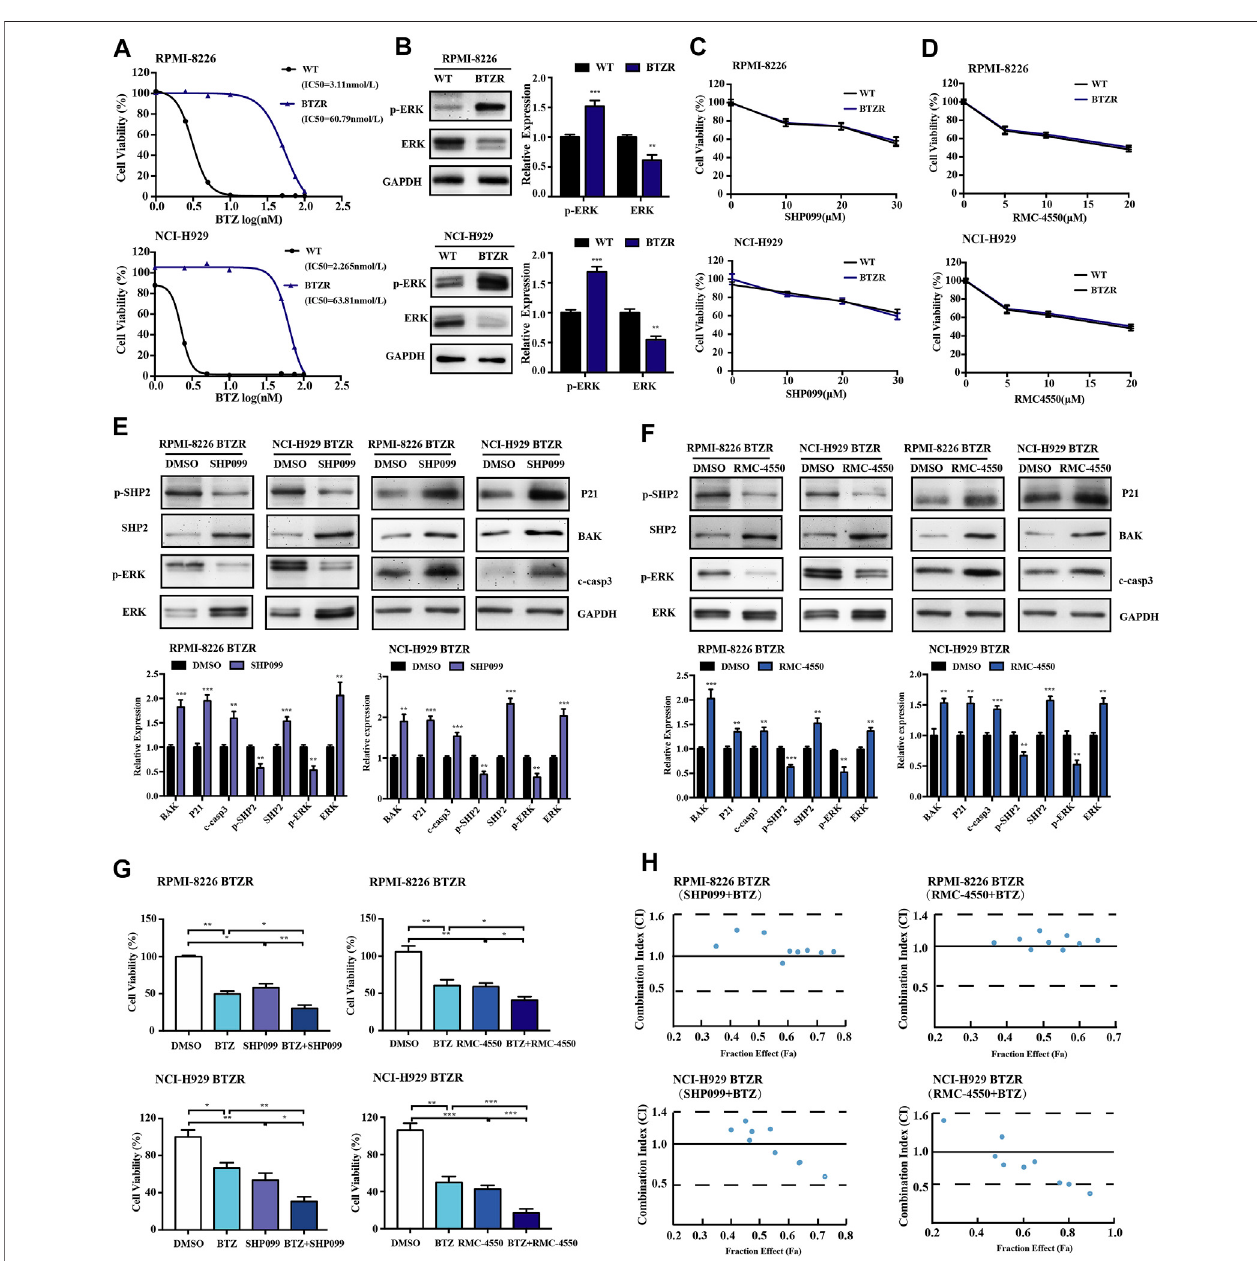
FIGURE 8 | Pharmacological inhibition of SHP2 with SHP099 or RMC-4550 is effective in suppressing the growth and overcoming bortezomib resistance in bortezomib-resistantMMcells. (A) Bortezomibnaïve(WT)andresistant(BTZR)myelomacells(RPMI-8226andNCI-H929cells)weretreatedwithvariousconcentrations of bortezomib for 48 h, and the IC 50 was calculated and shown. (B) Protein levels of p-ERK and ERK of the parental and bortezomib-resistant myeloma cells were detected by Western blot analysis. The bar graph illustrates the quantitative comparison of different proteins levels. (C,D) Pharmacological inhibition of SHP2 with SHP099 or RMC-4550 in bortezomib-resistant myeloma cells (BTZR) conferred a similar growth inhibition effect to that of bortezomib-naïve myeloma cells (WT). (E,F) After incubation with 20 µM SHP099 or 10 µM RMC-4550 in RPMI-8226 and NCI-H929 cells for 48 h, Western blots against p-SHP2, SHP2, p-ERK, ERK, P21, BAK, and cleaved caspase-3 were performed and quanti fi ed. (G) Bortezomib-resistant (RPMI-8226 BTZR or NCI-H929 BTZR) cells were treated with either bortezomib (50 nM),SHP2inhibitors(20 μ MSHP099 or10 μ MRMC-4550),orthecombinationfor48 h,followedbyassessmentforcellviability. (H) Bortezomib-resistantMM cells were incubated with different doses of BTZ and SHP2 inhibitors (SHP099 or RMC-4550) or with the combination of both for 48 h; the synergistic cytotoxic effects were determined using the combination index based on the data from cell viability assays. x-axis, fractional effect concentrations; y-axis, CI. Data were displayed as mean ± SD from three independent experiments. * p < 0.05, ** p < 0.01, and *** p < 0.001.